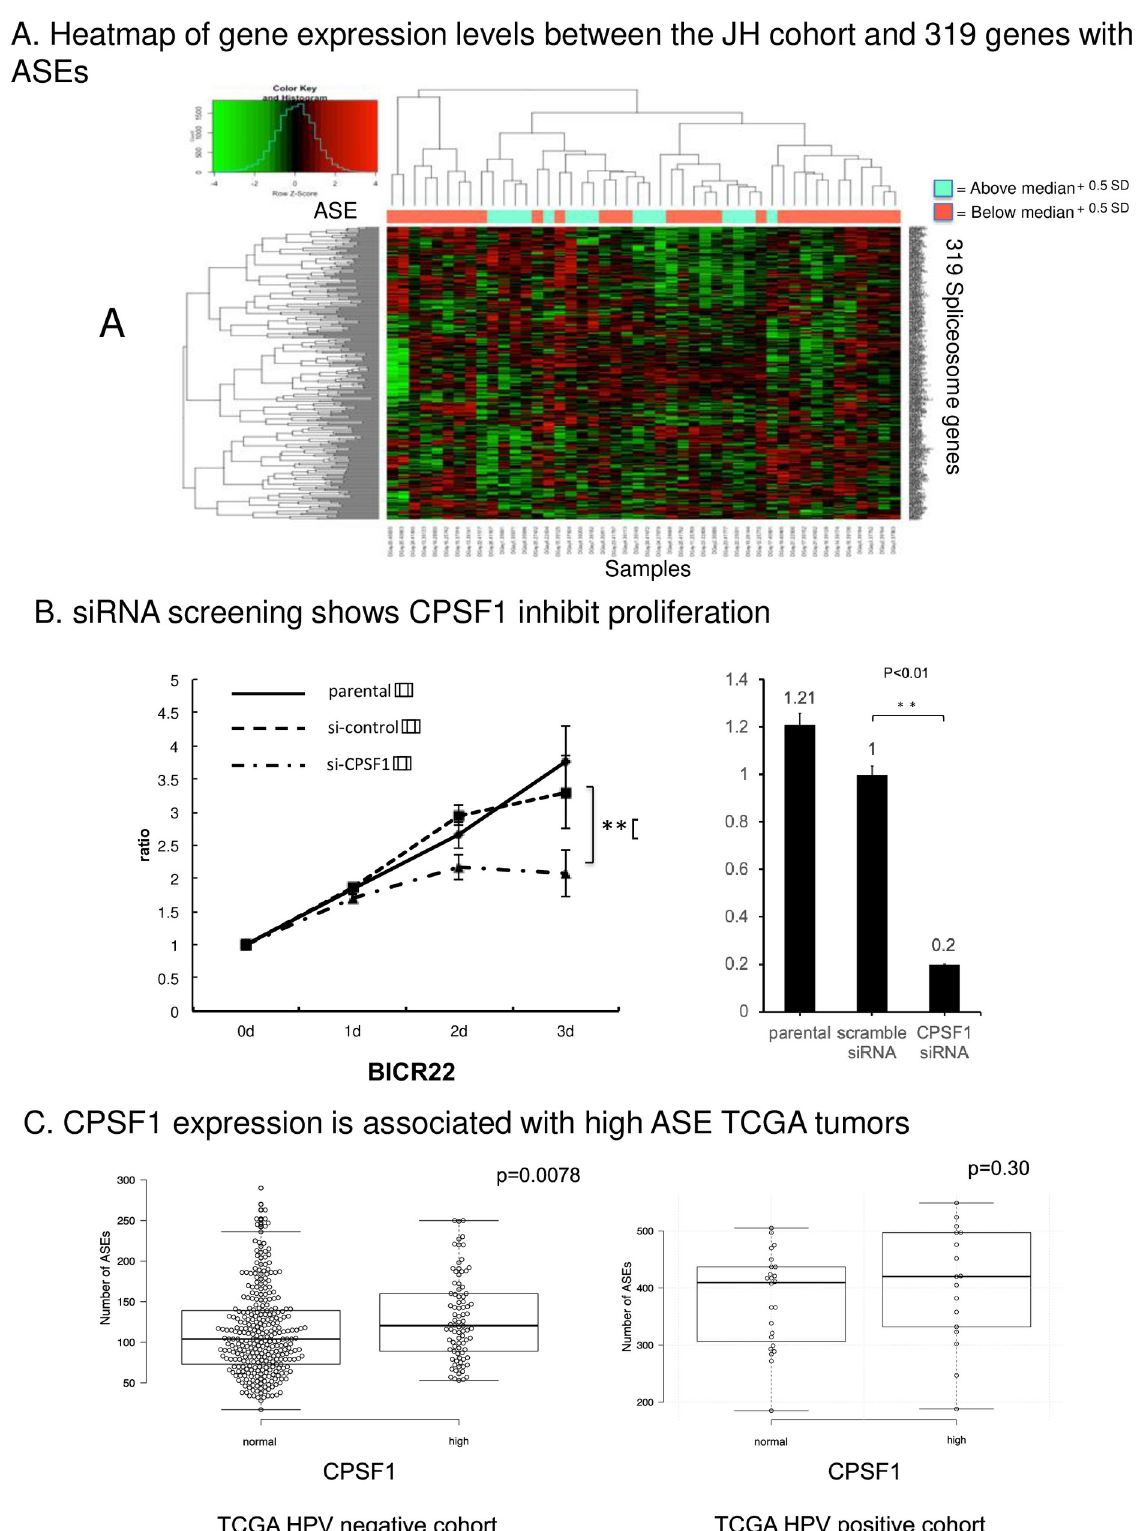
Fig 1. A. Heatmap of gene expression levels between the JH cohort and 319 genes with ASEs. Heatmap and hierarchical clustering of gene expression levels between samples in the Johns Hopkins cohort and 319 genes with alternative splice event numbers in each sample. There